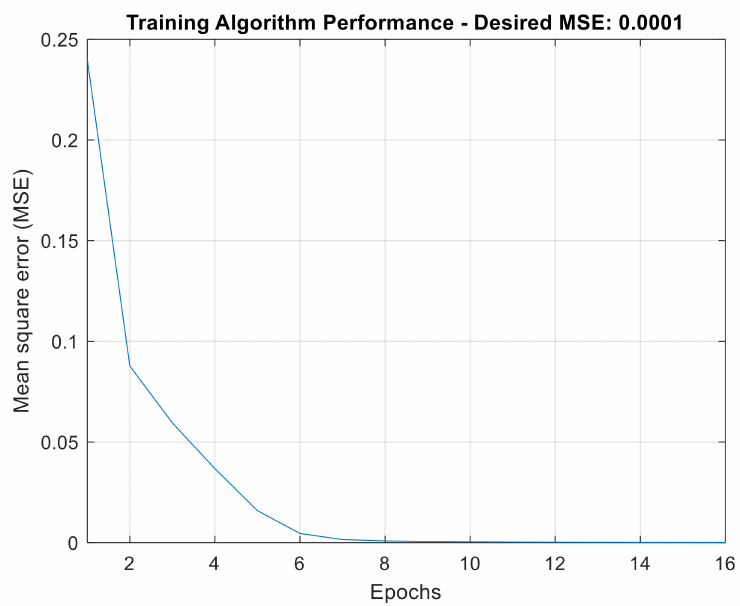
Figure 30. ANN training algorithm performance for FD-based strategy. Table 6. Minimum, average and maximum values of the FD extracted.